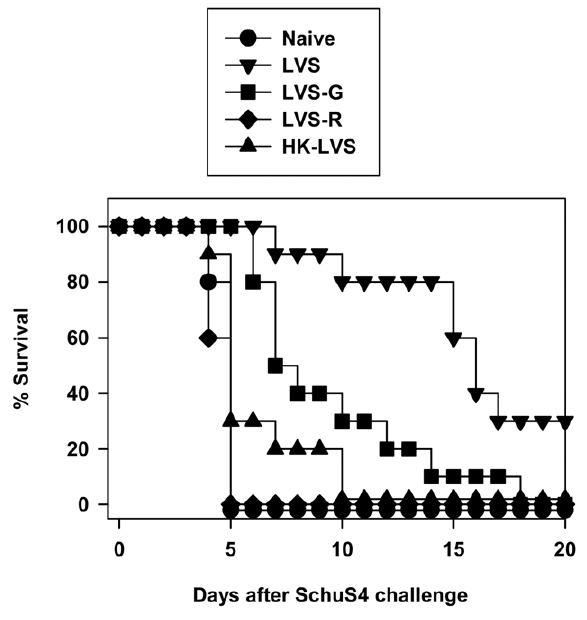
Figure 2. Hierarchy of survival against lethal systemic F. tularensis SchuS4 challenge after vaccination of mice with LVS or the variants LVS-G, LVS-R, and heat-killed LVS. Groups of five C57BL/6J mice were immunized by ID infection with 1 6 10 4 CFU LVS, ously (SC), and monitored for survival; all mice that survived through day 20 were long term survivors. The combined results of two independent experiments, using 10 total mice per vaccine group, are shown. By log-rank (Mantel-Cox) analysis, vaccination with LVS and LVS- G significantly improved survival (both p , 0.0001 compared to naive mice), and were significantly different from each other (p=0.0041); vaccination with HK-LVS or LVS-R did not significantly improved survival compared to naive mice (p=0.0968 or p=0.3425, respectively), but both of these were significantly different compared to vaccination with LVS or LVS-G (p , 0.0001 for all combinations).